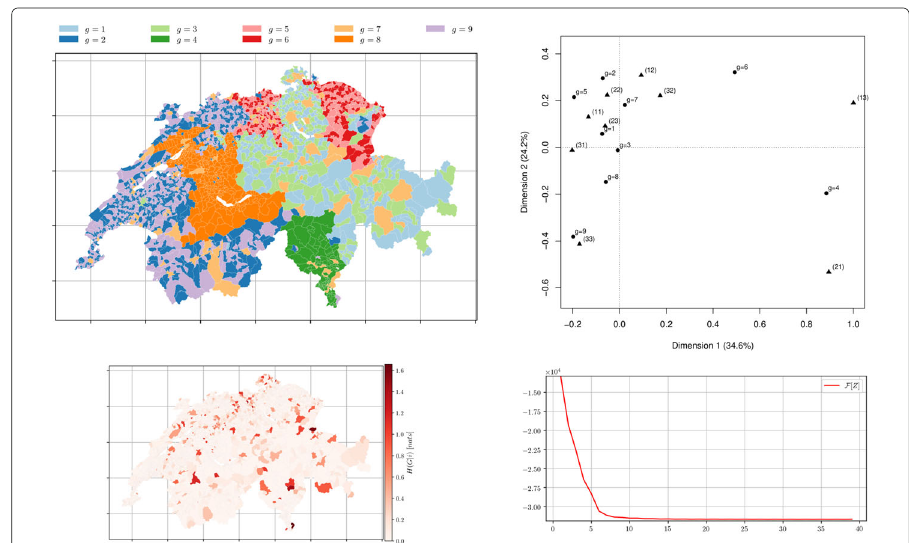
Fig. 11 Municipalitiessoftclusteringonallthetopics depicts the semi-supervised hard assignment obtained from a official classification Z 0 for m = 9 groups using distance matrix D obtained from topic modelling with k = 9 after 39 iterations. Lefttop Hard membership. Leftbottom the conditional entropy of topics H ( R | i ) showing municipality-topic probability distribution uncertainty. Righttop the CA bi-plot between Z ∞ ( • ) and the official classification ( (cid:2) ) with m = 9. Rightbottom The free-energy plot ( β = 10, α = 10)